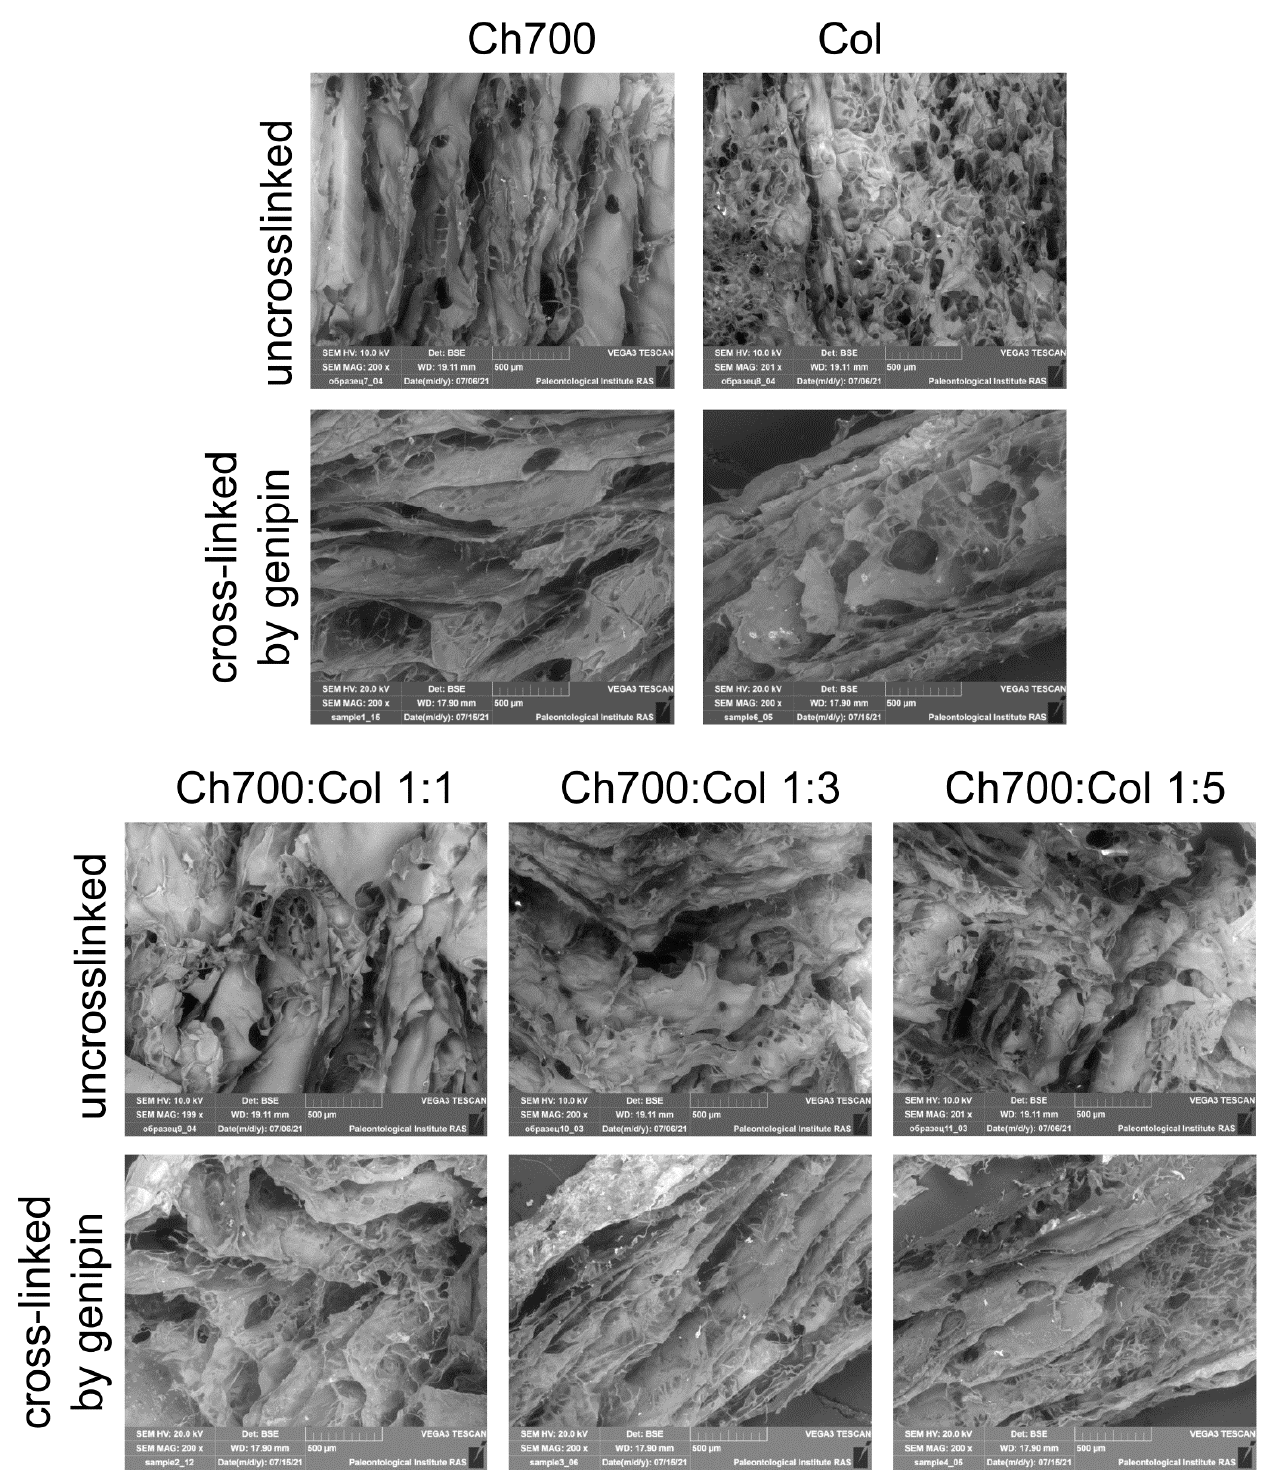
Figure 4. SEM image of the microstructure of the hydrogels with different ratios of collagen and chitosan (Bar = 500 μ m).